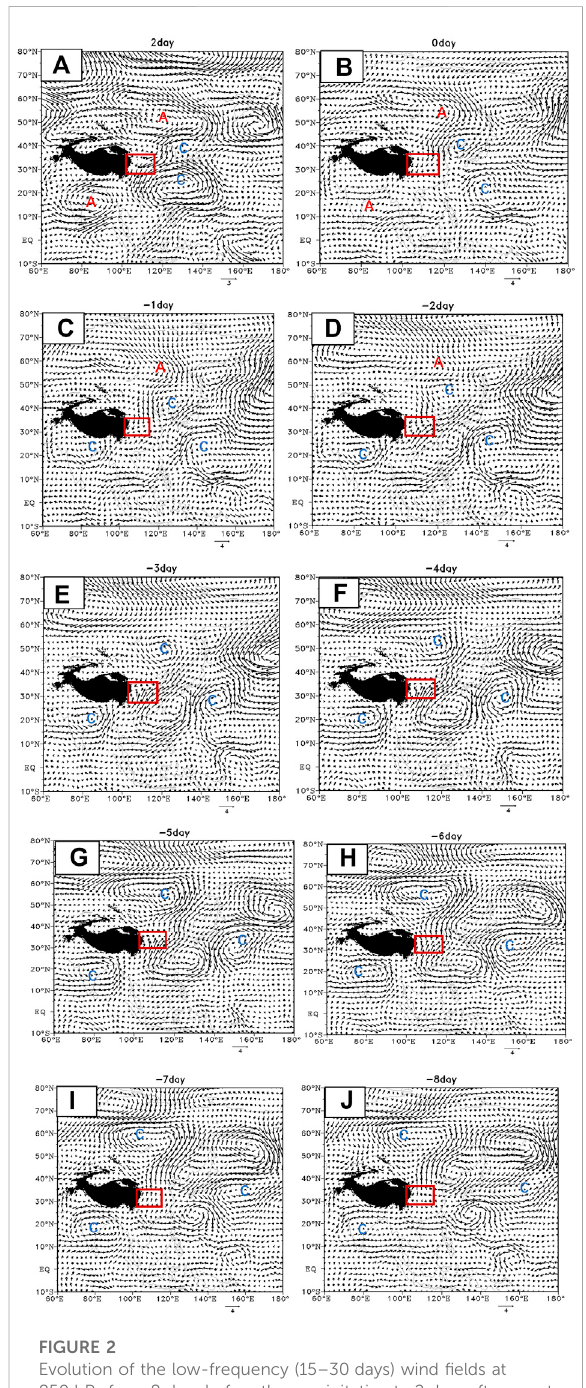
FIGURE 2 Evolution of the low-frequency (15 – 30 days) wind fi elds at 850 hPa from 8 days before the precipitation to 2 days after onset in Western Sichuan, unit: m/s (the box is the precipitation area in western Sichuan, A is thekey low-frequencyanticyclone,C is the key low-frequency cyclone. The same as below).